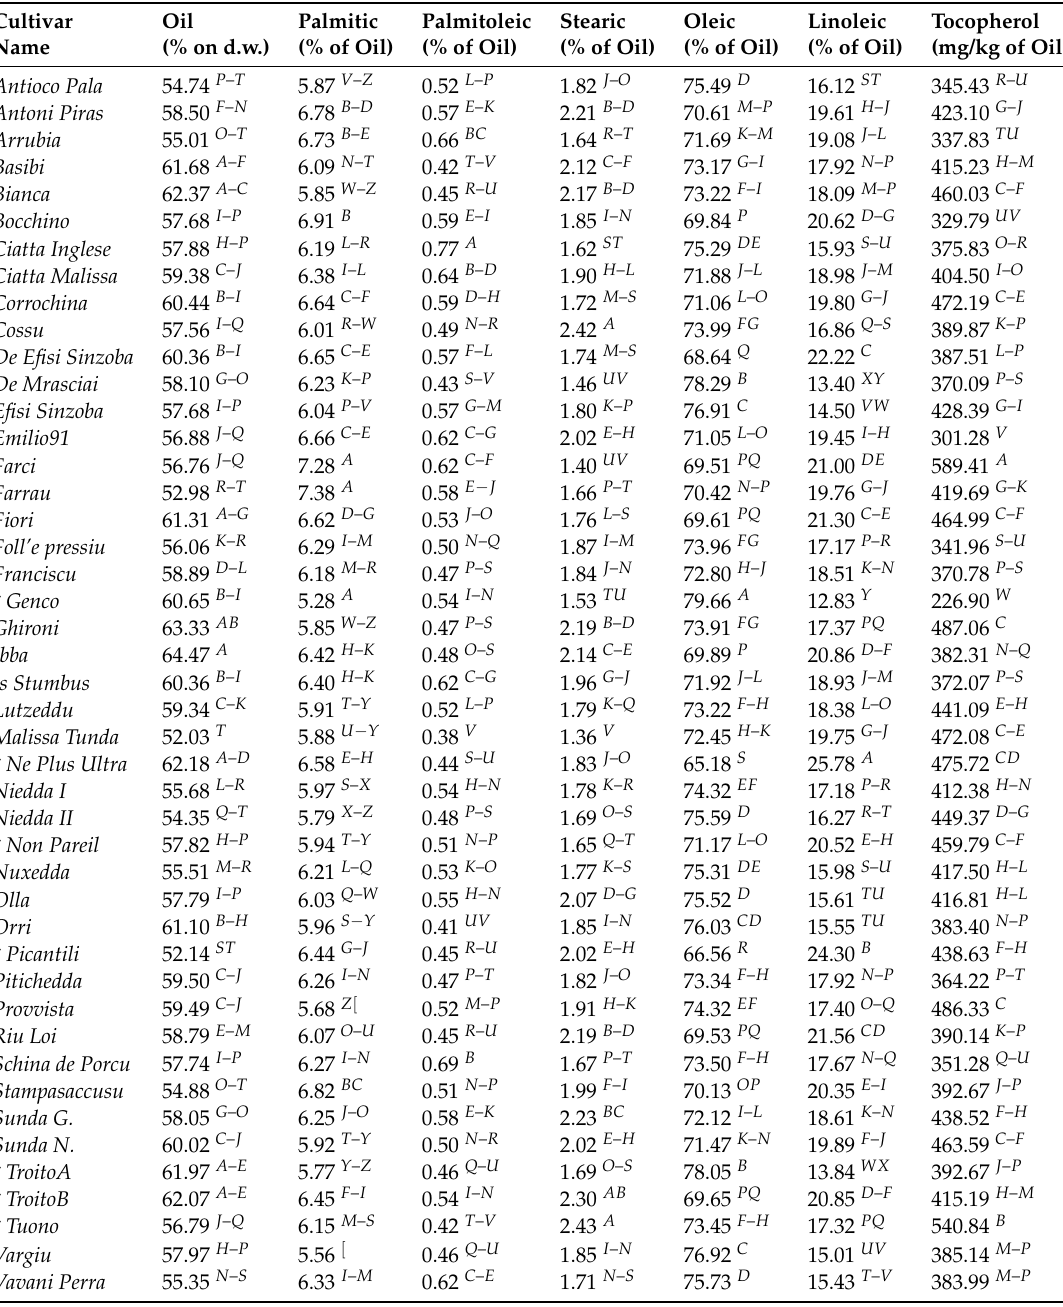
Table 5. Oil traits. The names of reference cultivars are preceded by an asterisk. (The capital letters represent Tukey–Kramer (TK) groups at p < 0.05. Cultivars sharing at least one TK symbol are not significantly different for the trait in the